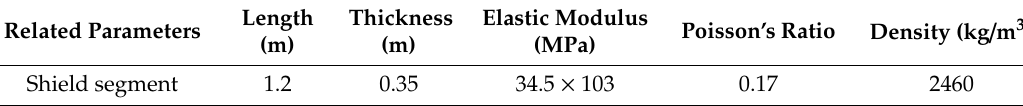
Table 5. Calculation parameters of shield segment